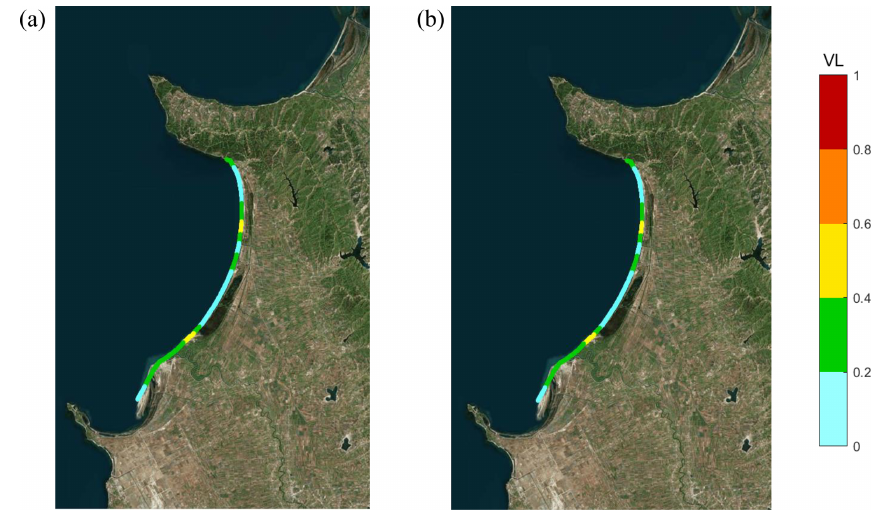
Figure 9. Run-up vulnerability levels for the Bay of Lalzit, using nearshore data for the 270–360 ◦ N sector: (a) 50-year return period; (b) 500-year return